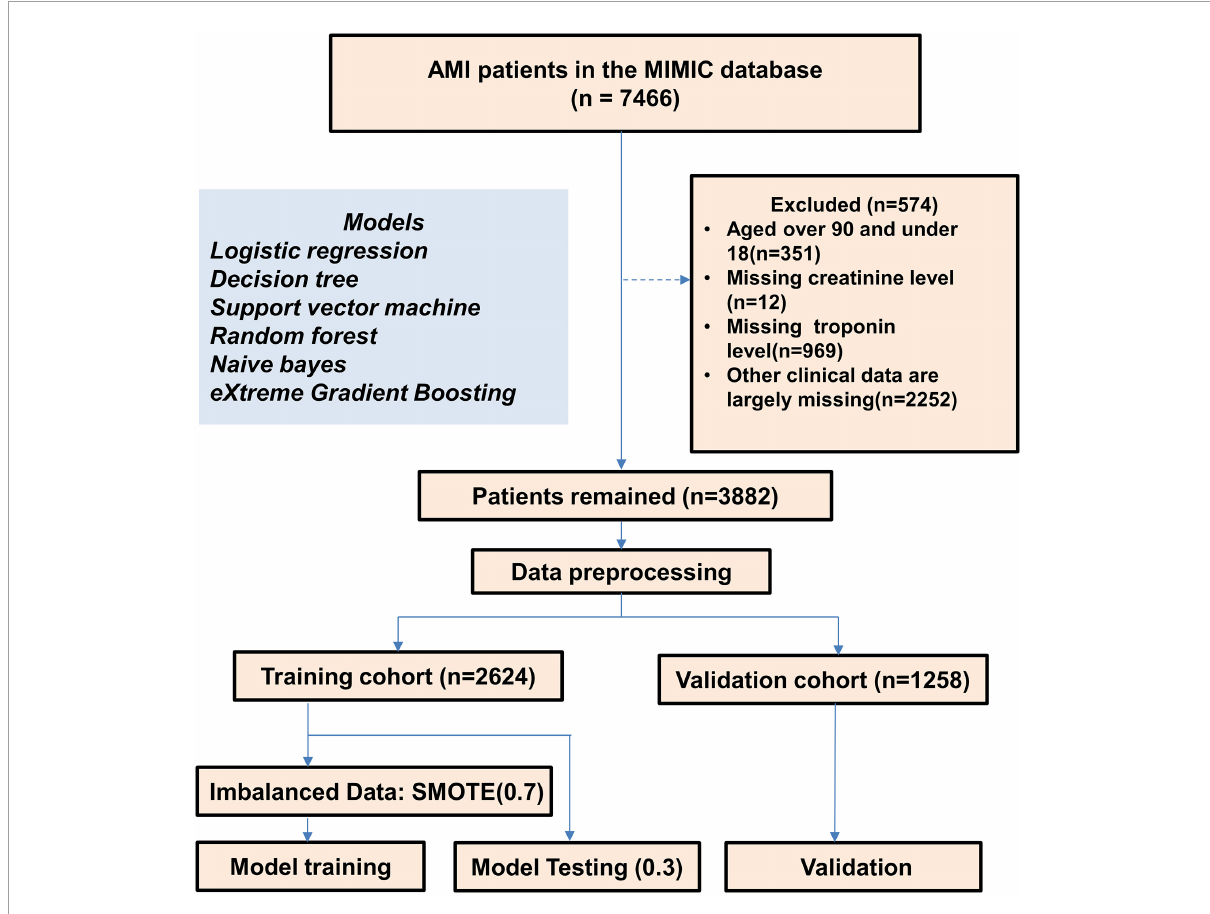
FIGURE1 Flow diagram of the selection process of